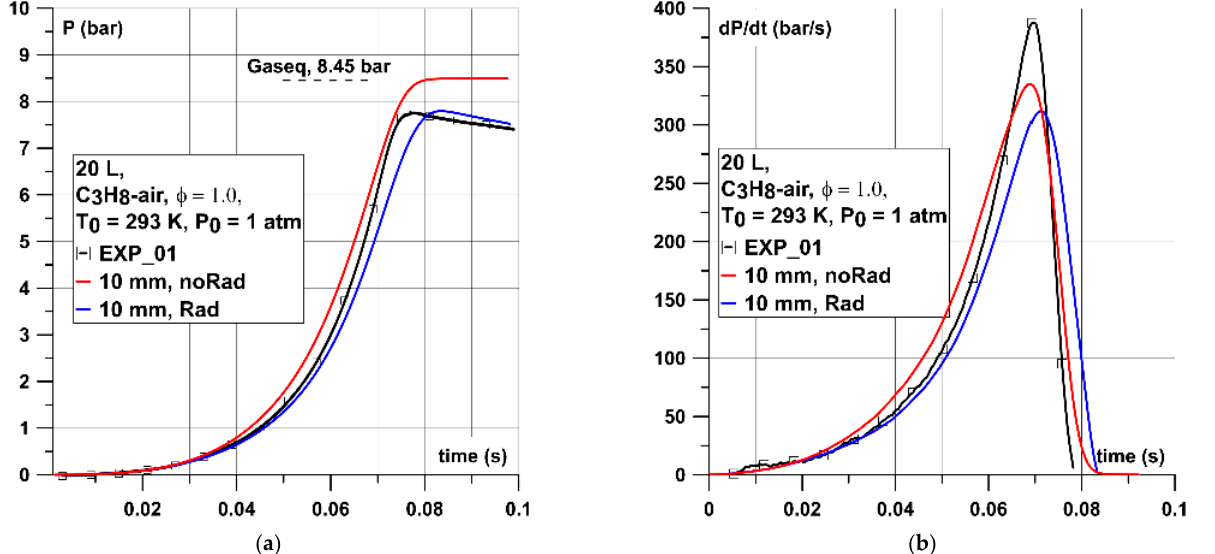
Figure 15. (a) Pressureand (b) dP/dt graphs for stoichiometric C 3 H 8 –air mixture in the 0.02 m 3 vessel.